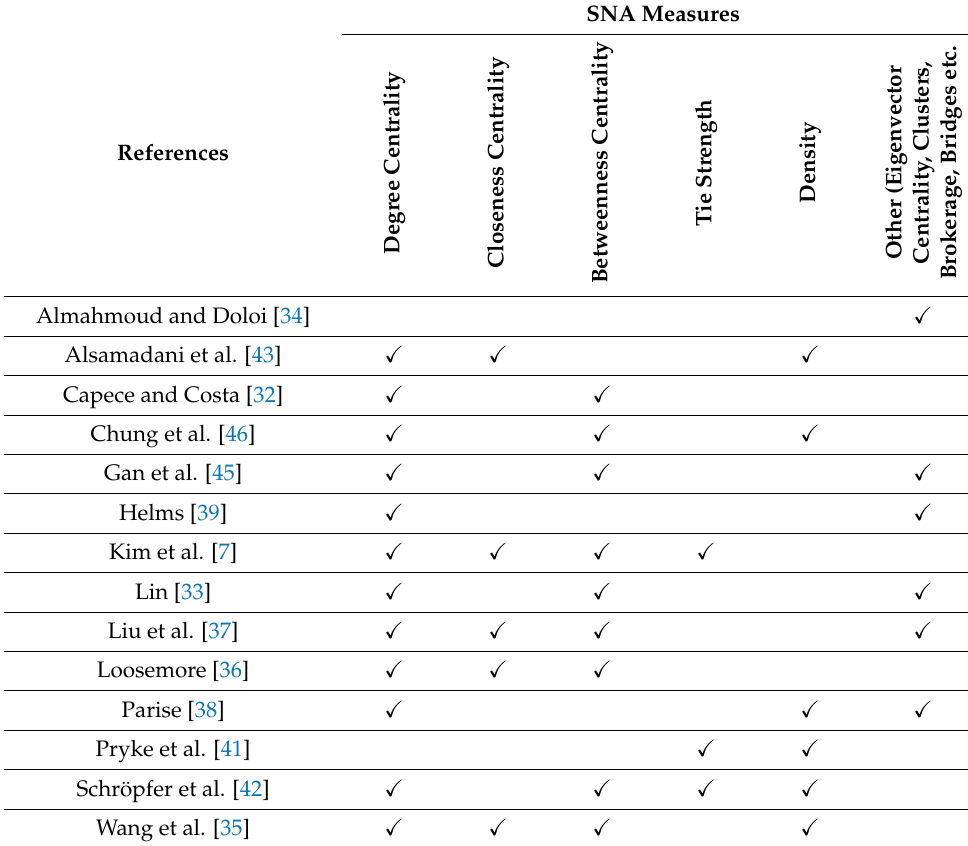
Table 3. Summary of SNA measures used by various